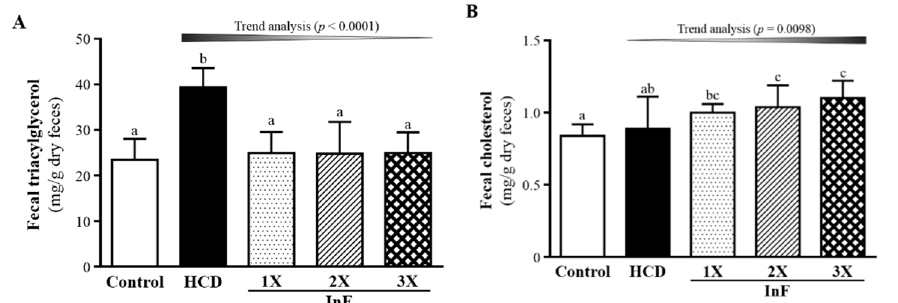
Figure 6. Effect of eight-week InF supplementation on fecal TG ( A ) and TC ( B ) levels in hyperlipidemic hamsters. Data are mean ± SD ( n = 8/group); values with different letters (a, b, c) differ significantly at p < 0.05 by one-way ANOVA.